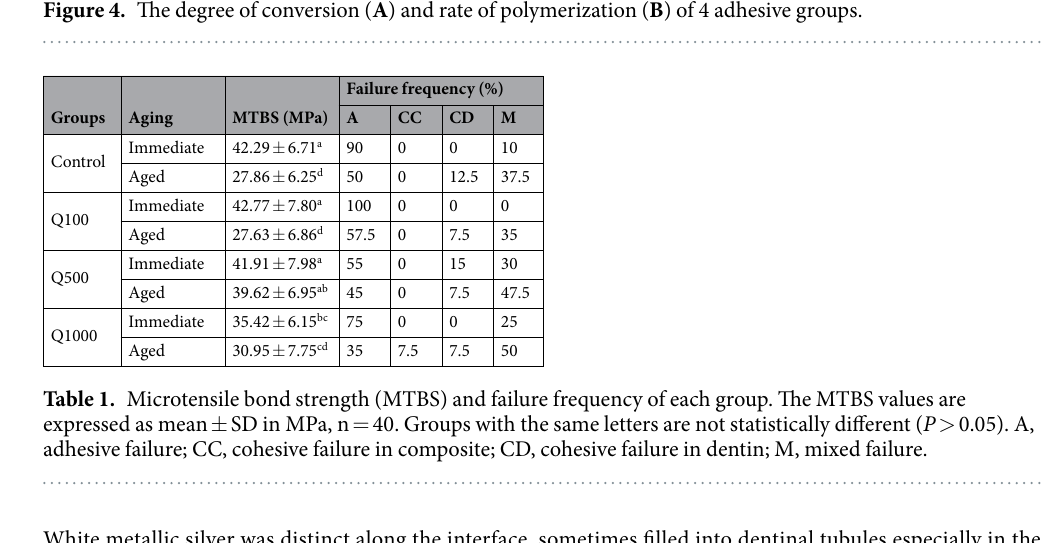
Figure 4. The degree of conversion ( A ) and rate of polymerization ( B ) of 4 adhesive groups.